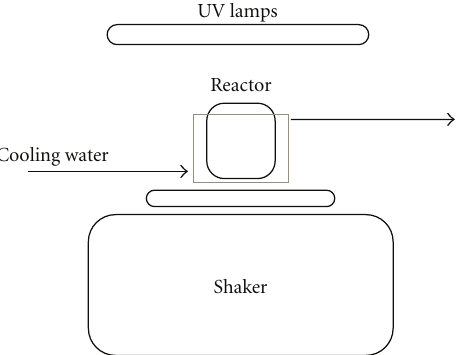
Figure 1: Schematic diagram of the photocatalytic system. Figure 2: The XRD pattern of nano-TiO 2 particle. Table 1: Adsorption of TEP on nano-TiO 2 surface (nano-TiO 2